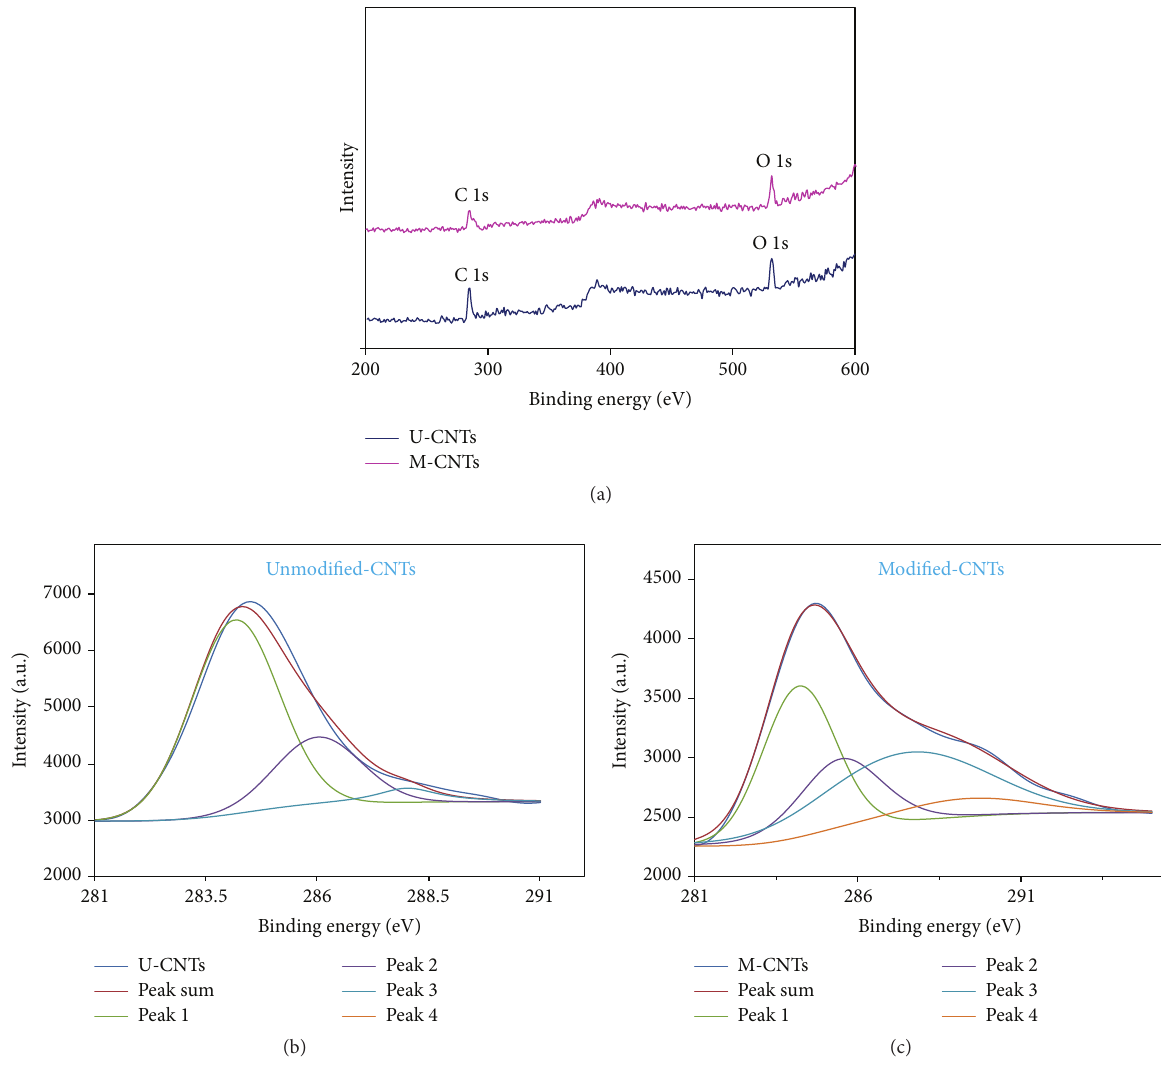
Figure 3: (a) XPS survey spectra of unmodified-carbon nanotubes (U-CNTs) and modified-carbon nanotubes (M-CNTs), C1s spectra of (b)